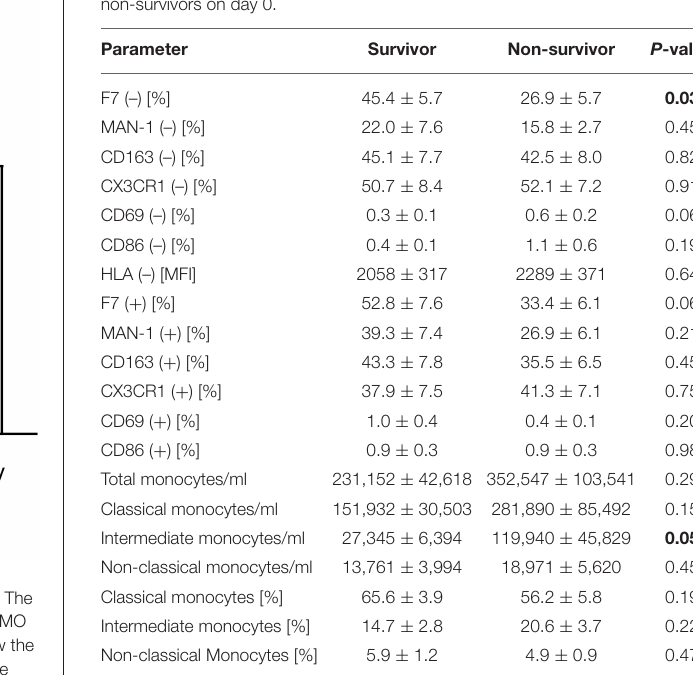
TABLE 2 | Parameters of monocyte function and distribution in survivors vs. non-survivors on day